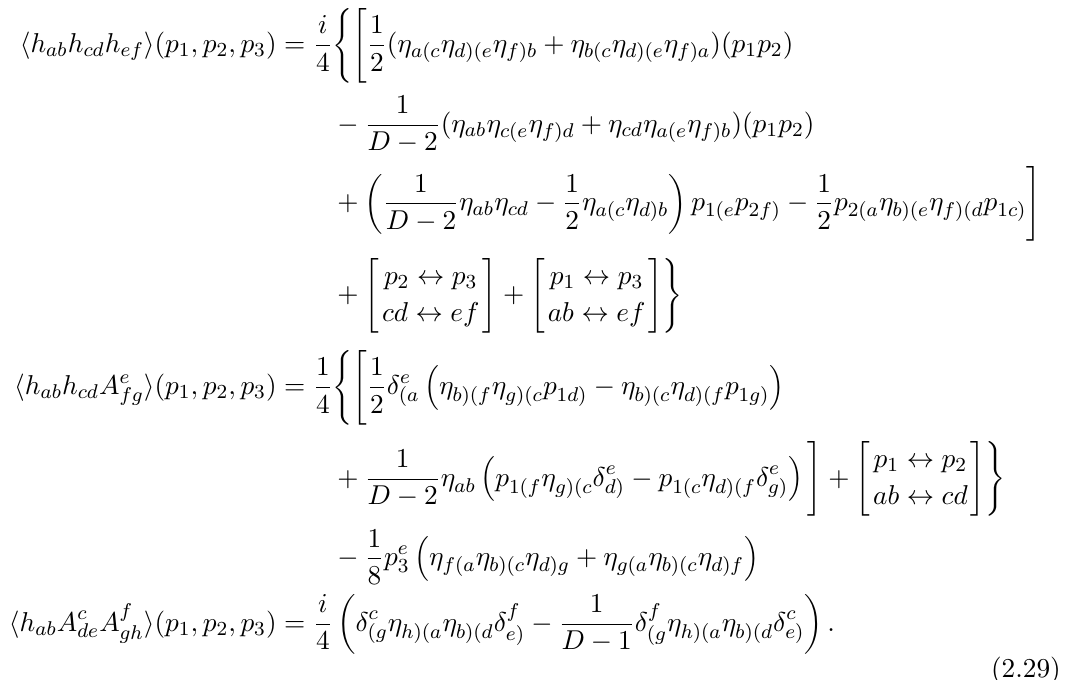
corresponding to propagation from A a i h h h h i ( p , p , p ) = 1 2 3 ab cd ef